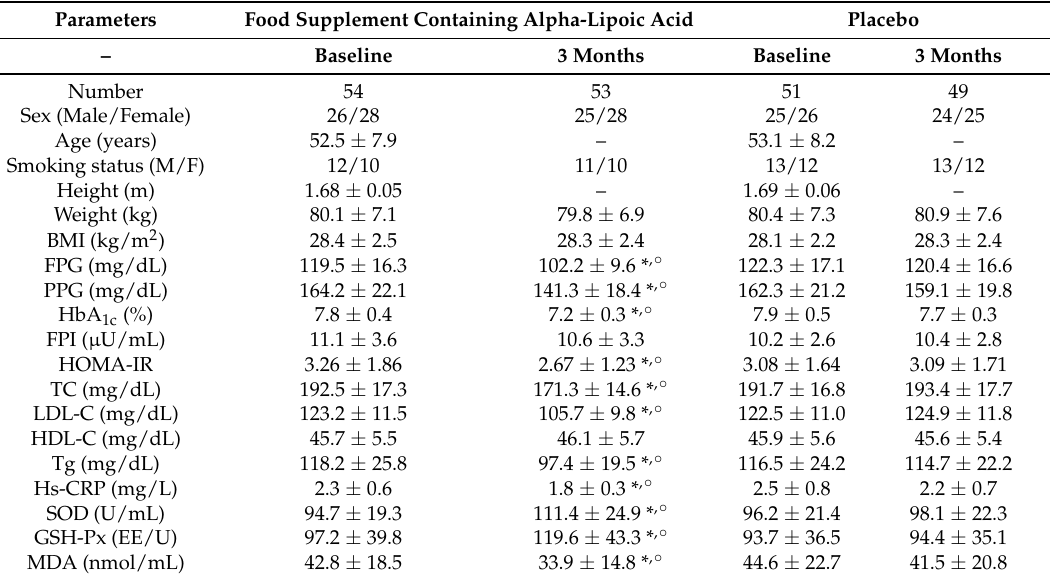
Table 1. Mean changes during the